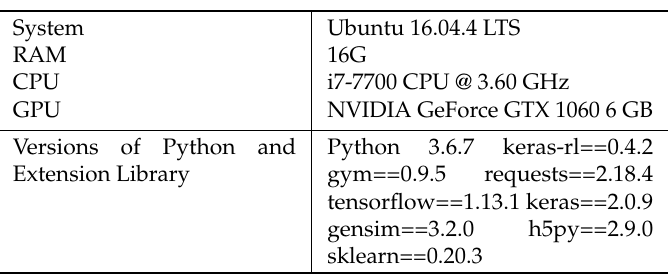
Table 1. Experiment